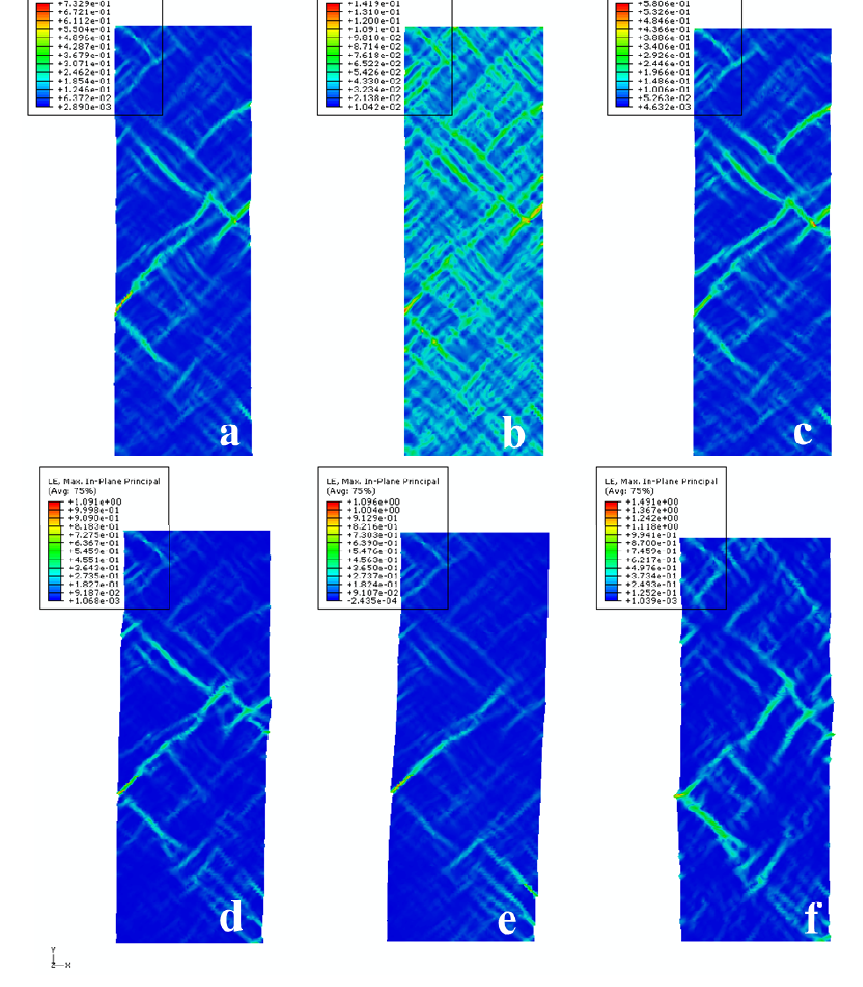
model, ( b ) J P model, 2 2 model, ( e ) J P model, 2 2